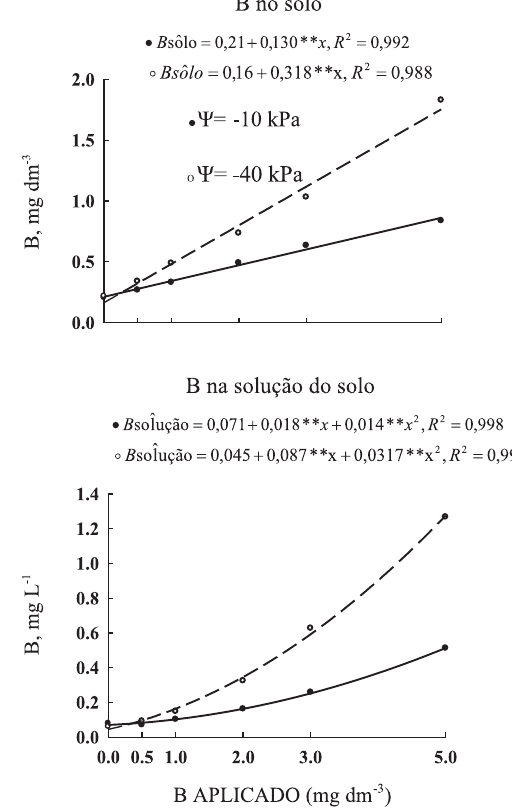
Figura 3. Teores de B no solo e B na solução do solo em resposta às doses de B (B aplicado), considerando o potencial de água do solo ( ΨΨΨΨΨ ). ** significativo a 1 % pelo teste